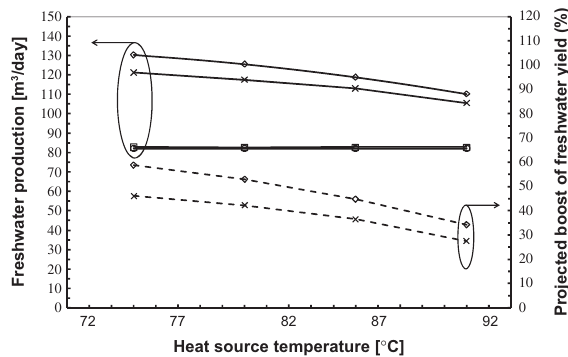
Figure 5. The efficacy of the novel MED design applied to a four- effect distillation plant. s , freshwater yield in a standard four-effect distillation plant at a cooling water temperature of 25 (cid:2) C; h , freshwater yield of a standard four-effect distillation plant at a cooling water temperature of 32 (cid:2) C. e , freshwater yield and improvement by using our proposed design at 25 (cid:2) C; · , freshwater yield and improvement by using the proposed design at 32 (cid:2) C [4].